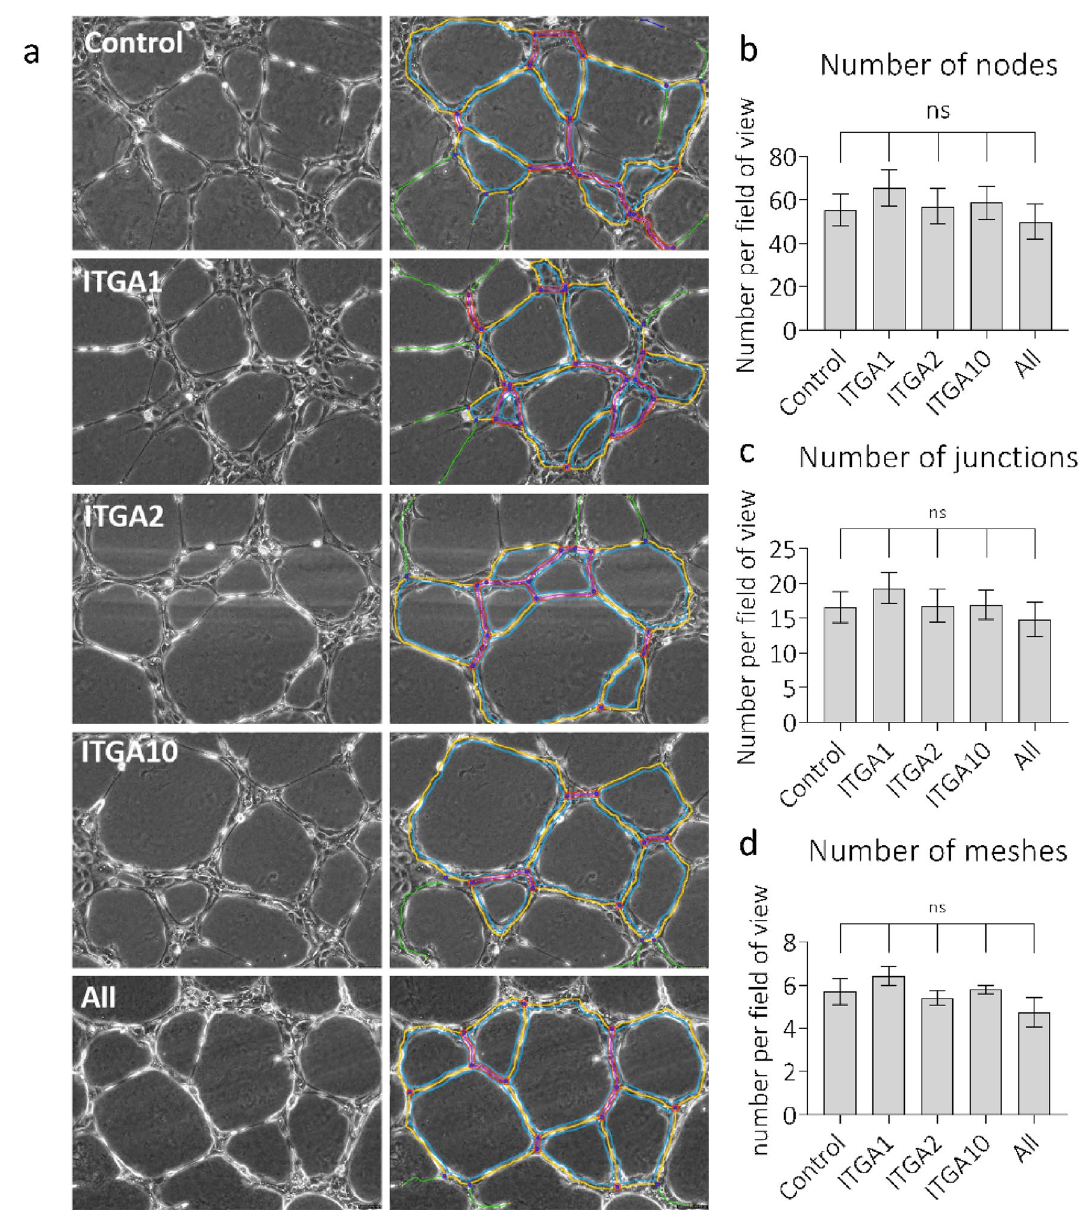
Figure 8. Quantification of tube formation after siRNA treatment. ( a ) Phase contrast images taken 6 h after seeding siRNA treated HUVECs on Geltrex 3D matrices. HUVECs were seeded 48 h after siRNA treatment. The left column of images indicates phase contrast images, the right column indicates the angiogenesis analyser overlay. The quantification of tube formation as the number of ( b ) nodes, ( c ) junctions or ( d ) meshes per field of view after knockdown of the indicated integrin α subunits. Error bars indicate SEM calculated from three repeats performed in